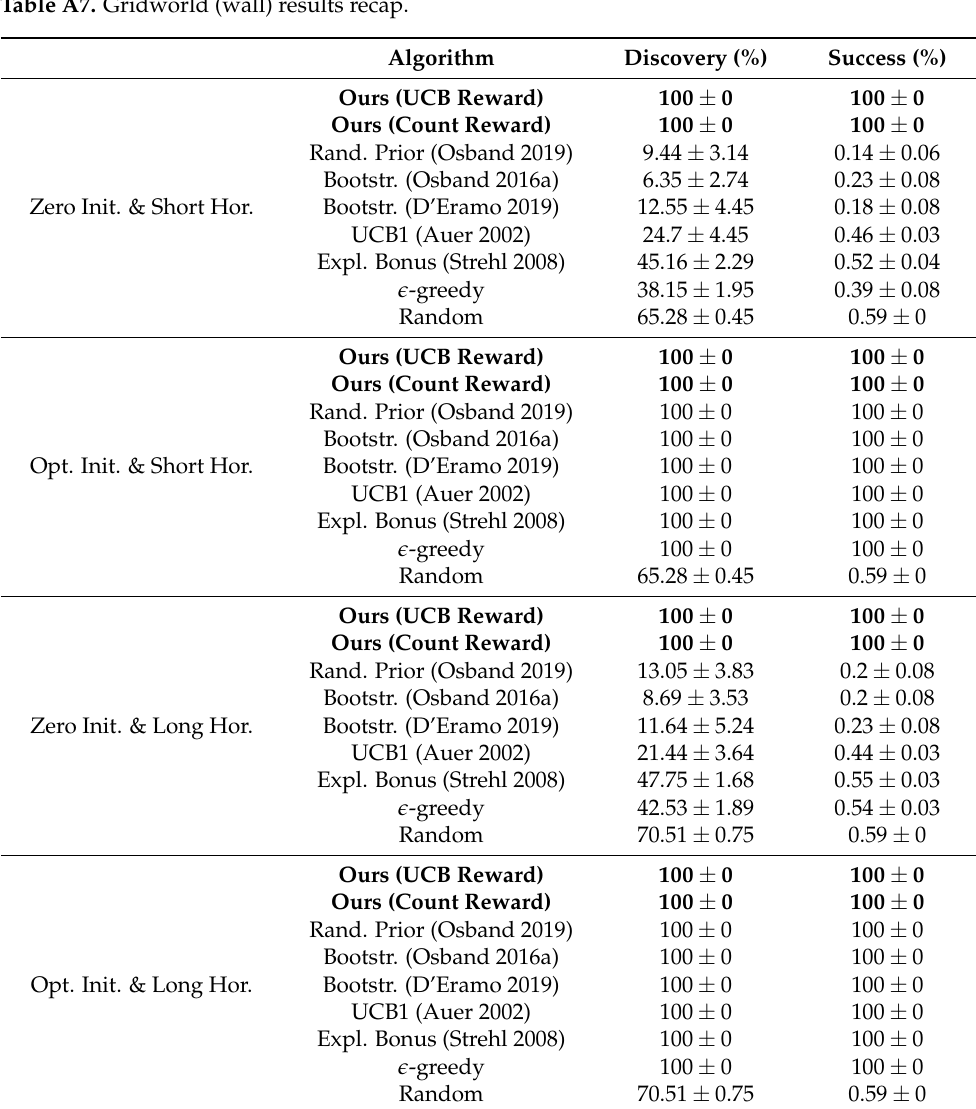
Table A7. Gridworld (wall) results